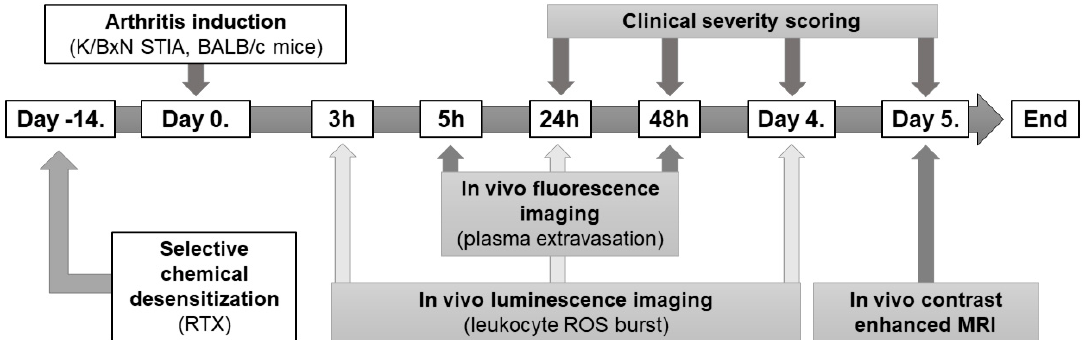
Figure 1. Flowchart summary of the experimental protocol.